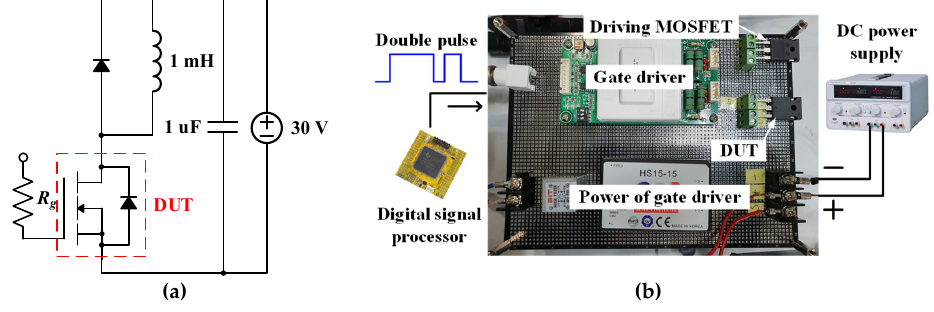
Figure 10. R on variations in NHEF stress: ( a ) Si IGBT, ( b ) Si MOSFET, ( c ) Si IGBT with SiC diode, and ( d ) SiC MOSFET.